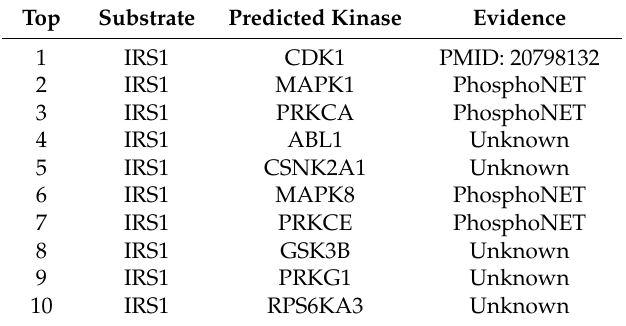
Table 1. The top 10 potential kinases of IRS1 predicted by